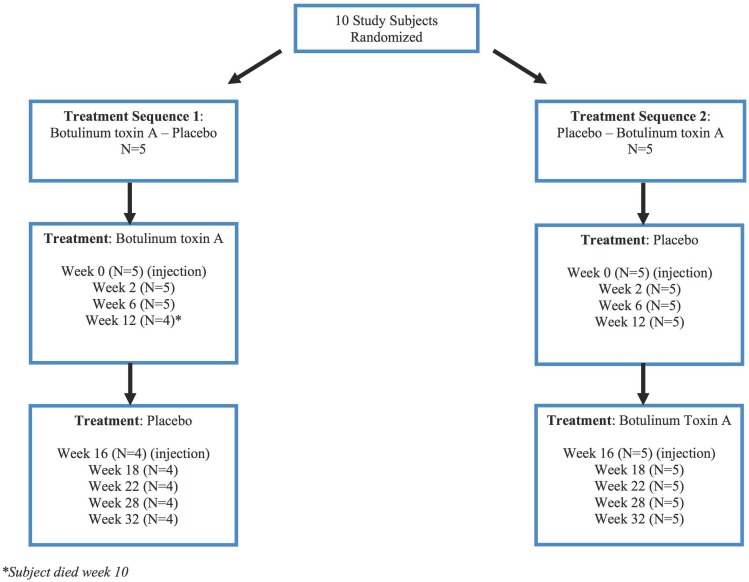
Study flow diagram.